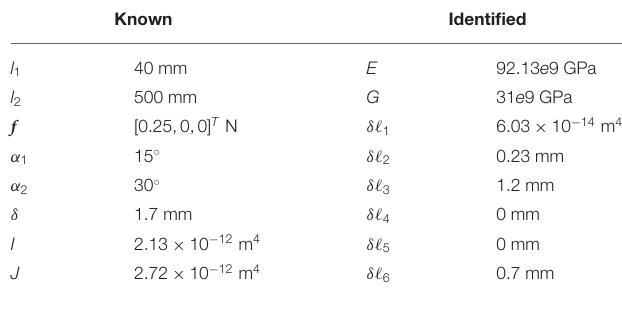
TABLE 1 | Physical parameters of the robot.